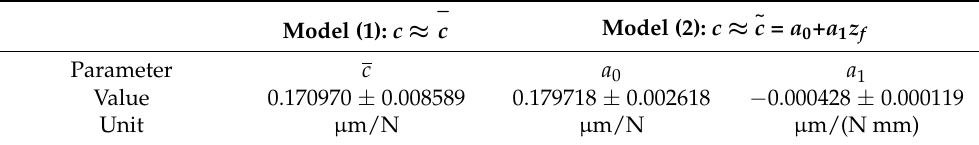
Table 3. Resulting compliance model coefficients and standard